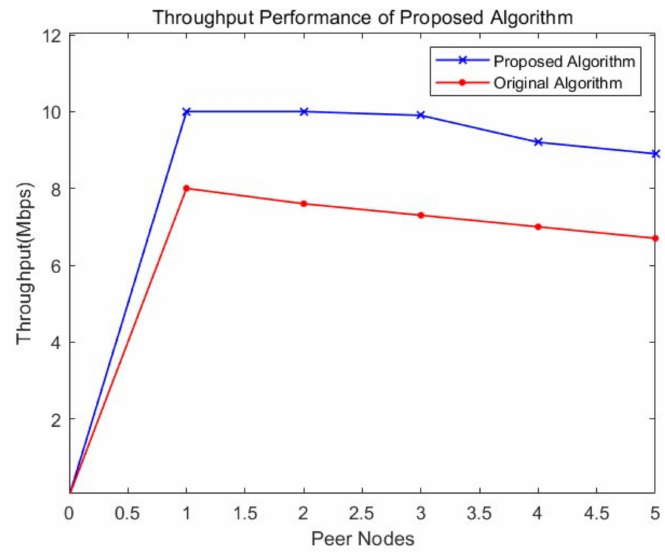
Figure 5. Authenticated time of the proposed Blockchain